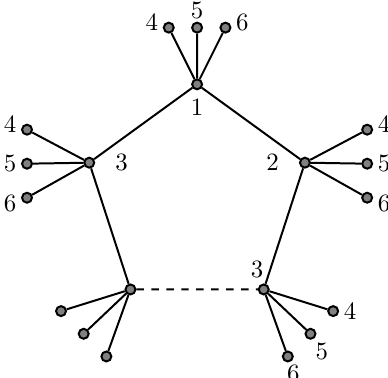
Figure 9: A subgraph of a 5 -regular graph G of girth at least